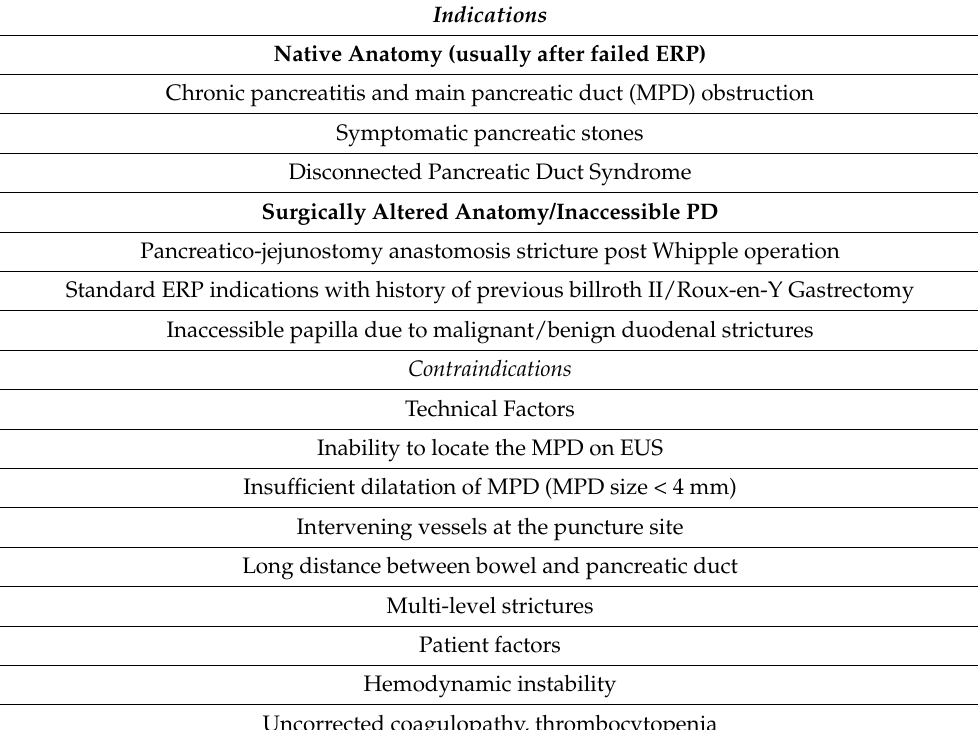
Table 1. Indications and contraindications of EUS- PDD